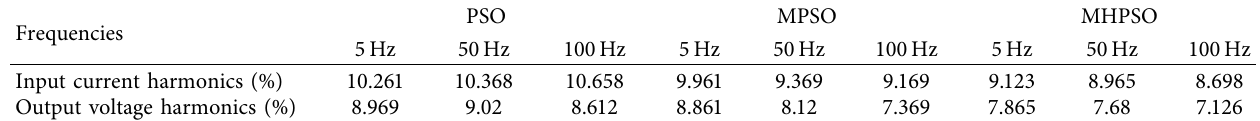
Table 3: Proposed methods for THD comparison results for various frequencies.